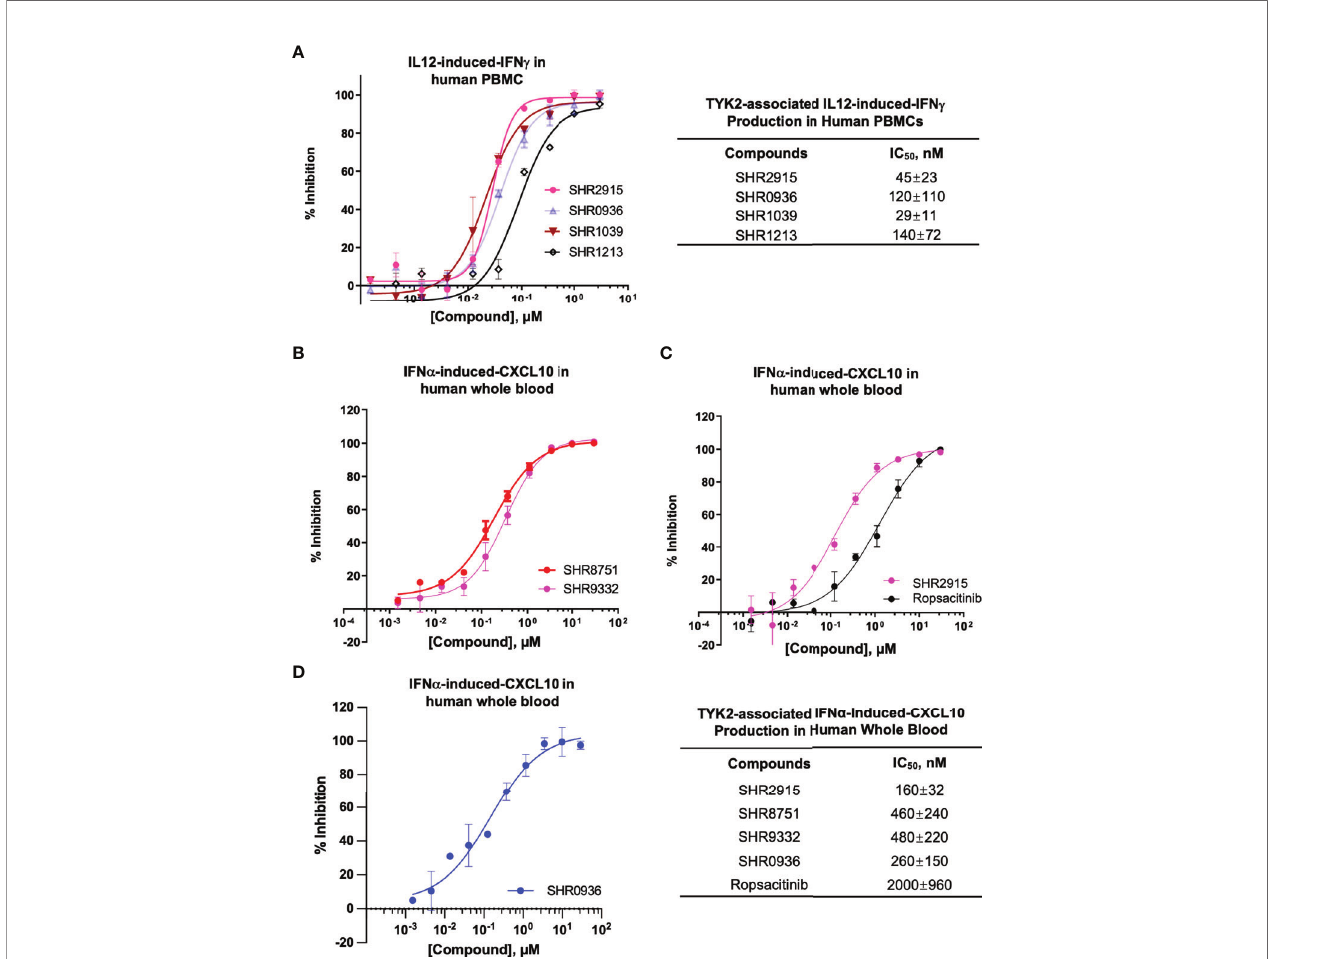
FIGURE 4 | TYK2 pseudokinase ligands demonstrate signi fi cant functional activity in suppressing IL12- or IFN a - mediated TYK2/STAT pathways in human PBMCs and whole blood. (A) Dose dependent response of TYK2 JH2 ligands, SHR2915, 0936, 1039 and 1213 on IL12-induced IFN g production in human PBMCs. 1.0 × 10 6 /ml PBMCs were treated by serially diluted (30 m M, 1:3) compounds and incubated with hIL12 for overnight in complete RPMI. The cultured supernatant was collected for detection of IFN g secretion using AlphaLISA method. (B-D) Dose dependent effect of TYK2 JH2 ligands, SHR8751 and 9332 (B) , SHR2915 and Ropsacitinib (C) and SHR0936 (D) on IFN a -stimulated CXCL10 production in human whole blood. Blood samples were incubated with serially diluted compounds (30 m M, 1:3) and stimulated with recombinant human IFN a overnight. The plasma was collected for detection of CXCL10 production by AlphaLISA method. Inhibition data were calculated by comparison to vehicle control wells for 0% inhibition and non-stimulated control wells for 100% inhibition. IC 50 values were derived by non-linear regression analysis using GraphPad Prism. The fi gures are representative of the experiments on specimens from three different donors with duplicates performed for each donor. The average IC 50 values and standard deviations of each compound from experiments on three donors are calculated and summarized in the